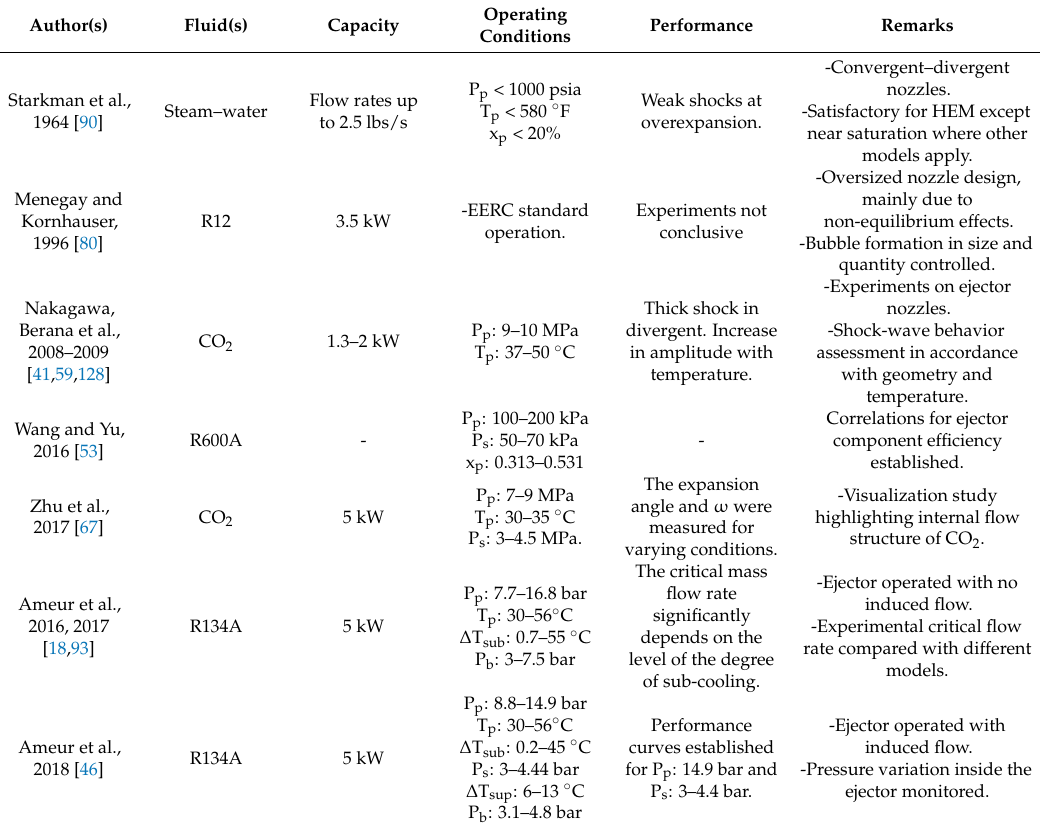
Table 3. Experiments on ejector